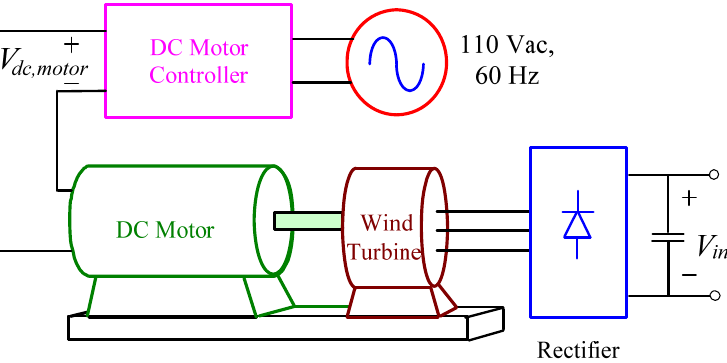
Figure 10. The emulator simulation system for the wind energy generator.